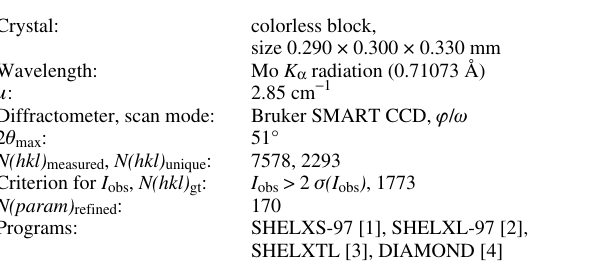
Table 1. Data collection and handling.